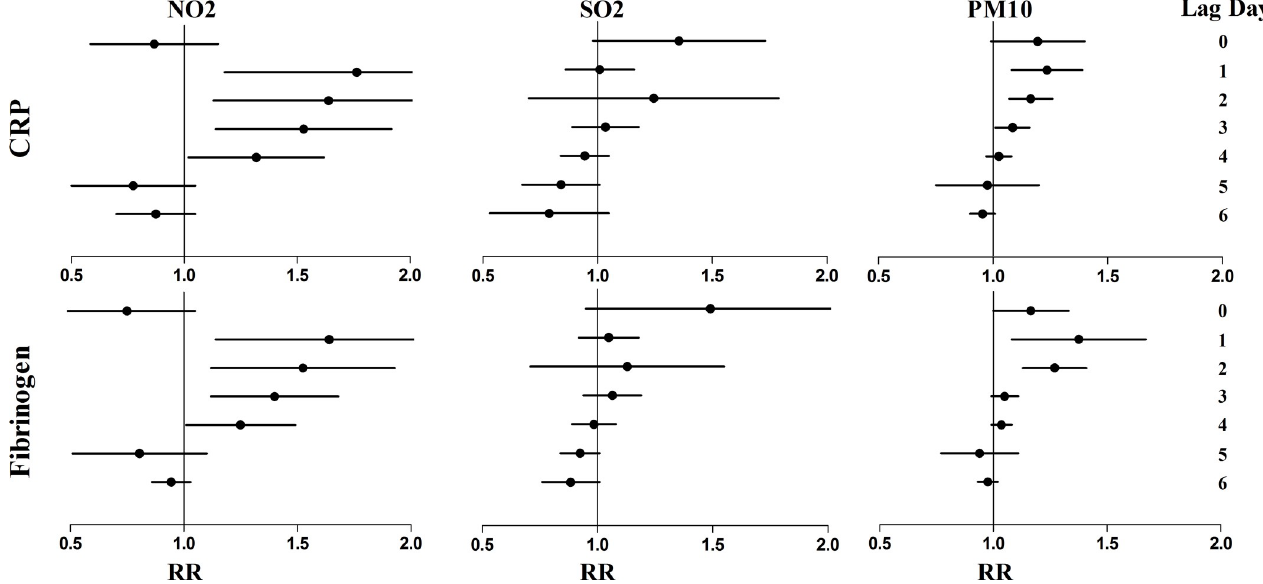
Fig 3. RRs and 95% CI estimates for the changes in biomarkers indicating systemic inflammation for CRP and fibrinogen associated with each 10 μ g/m 3 change in pollutant levels, by a 24-hour lag period. The lag time represents hours before a clinic visit. Zero lag represents 0 to 23 hours; lag 1, 24 to 47 hours; lag 2, 48 to 71 hours; lag 3, 72 to 95 hours; lag 4, 96 to 119 hours; lag 5, 120 to 143 hours; and lag 6, 144 to 167